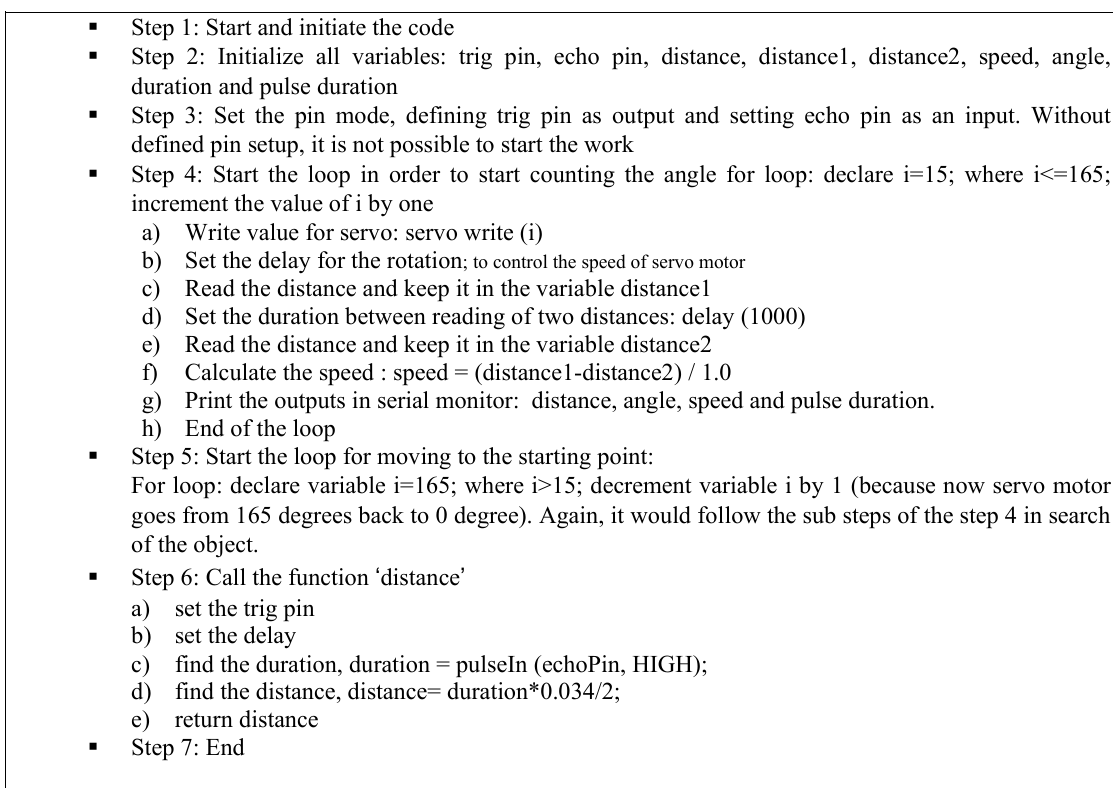
Fig. 3 Algorithm to calculate the velocity of the